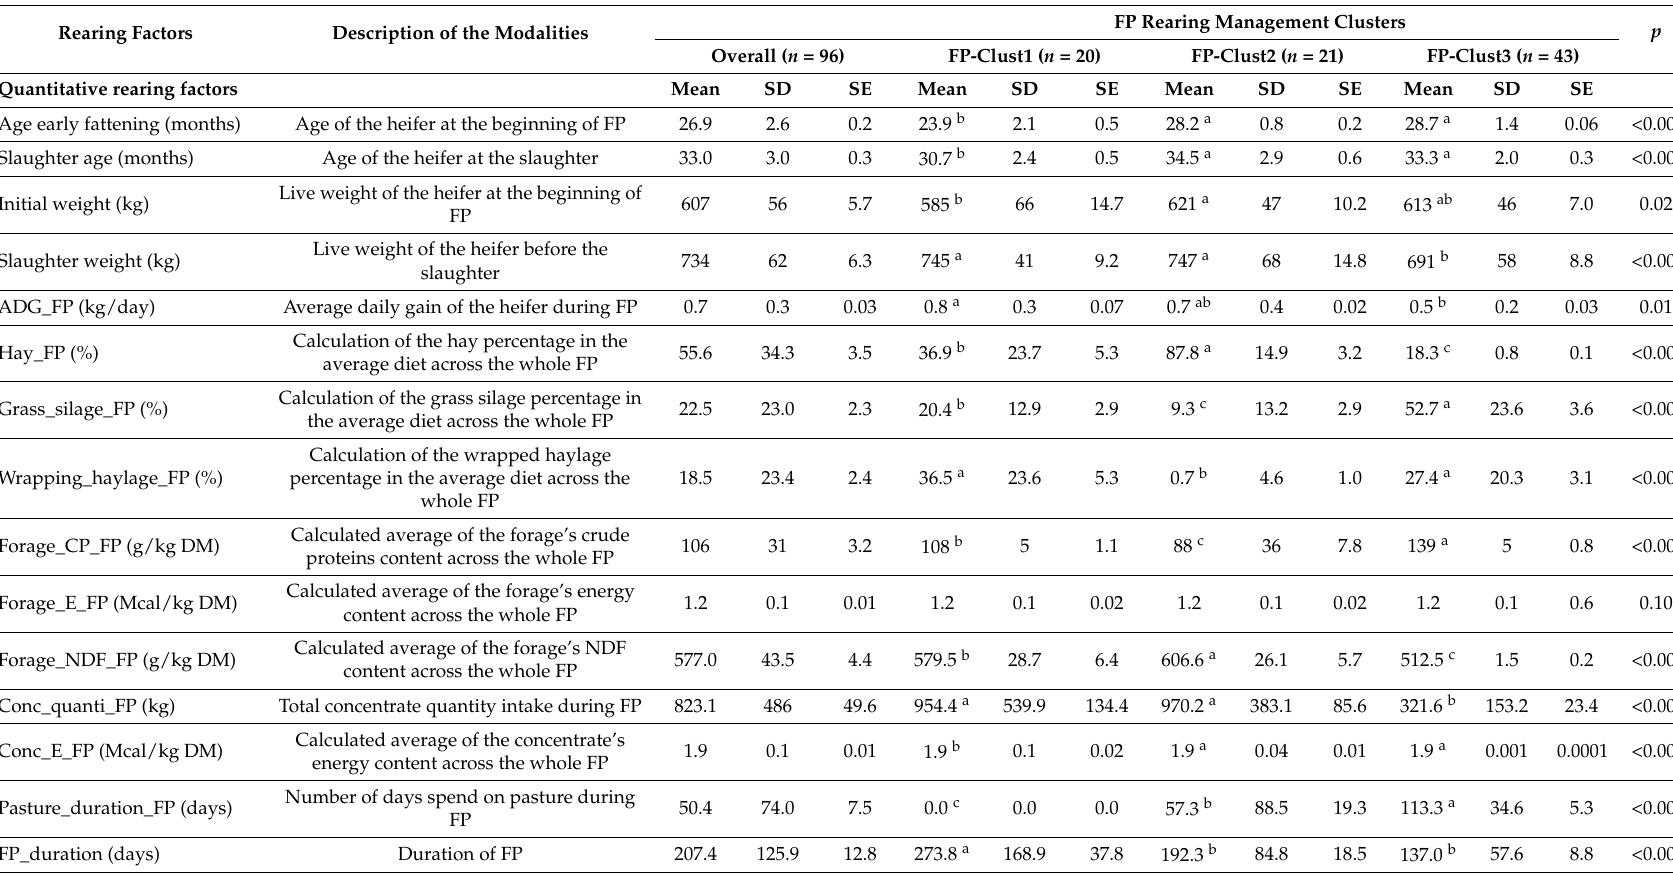
Table 3. Description of the rearing factors characterizing the fattening period (FP) and the FP rearing management clusters for this period (FP-clust). Rearing